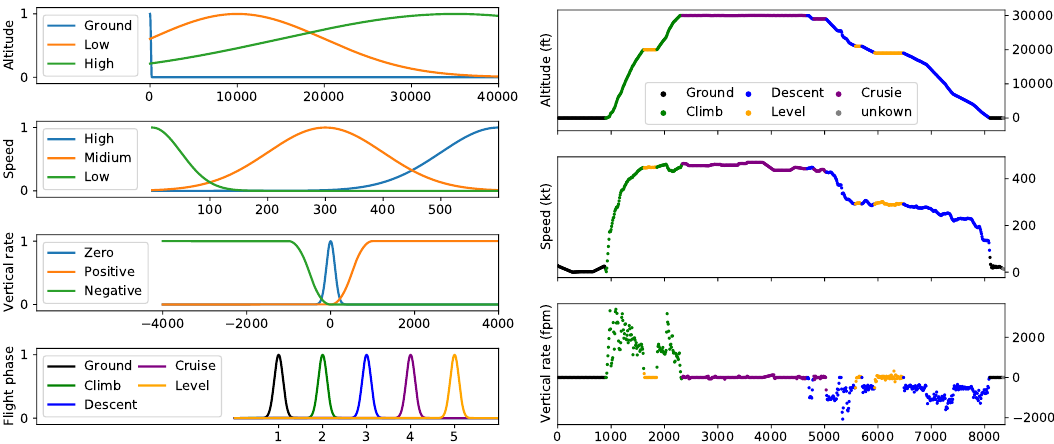
Figure 5. Example of flight phase identification using fuzzy logic, with fuzzy logic member functions (left) and the vertical profile with identified flight phases